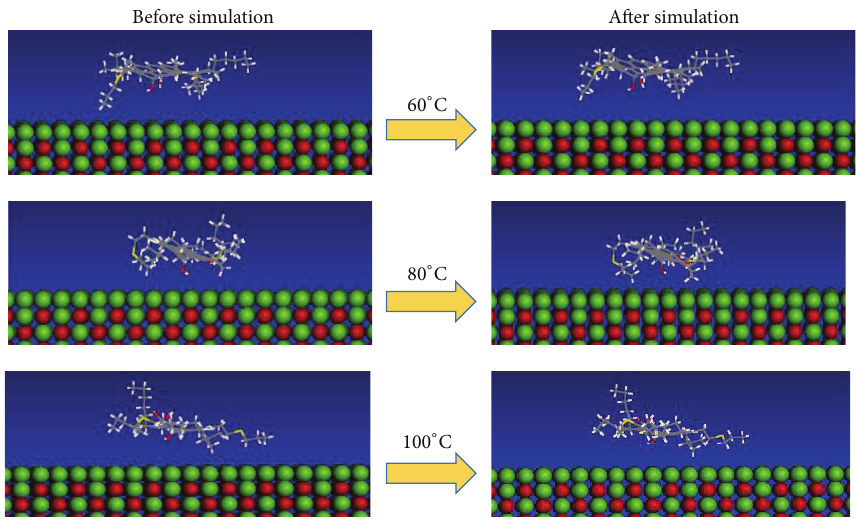
Figure 13: The interface configuration of asphaltene/MgO (60–100 ∘ C).